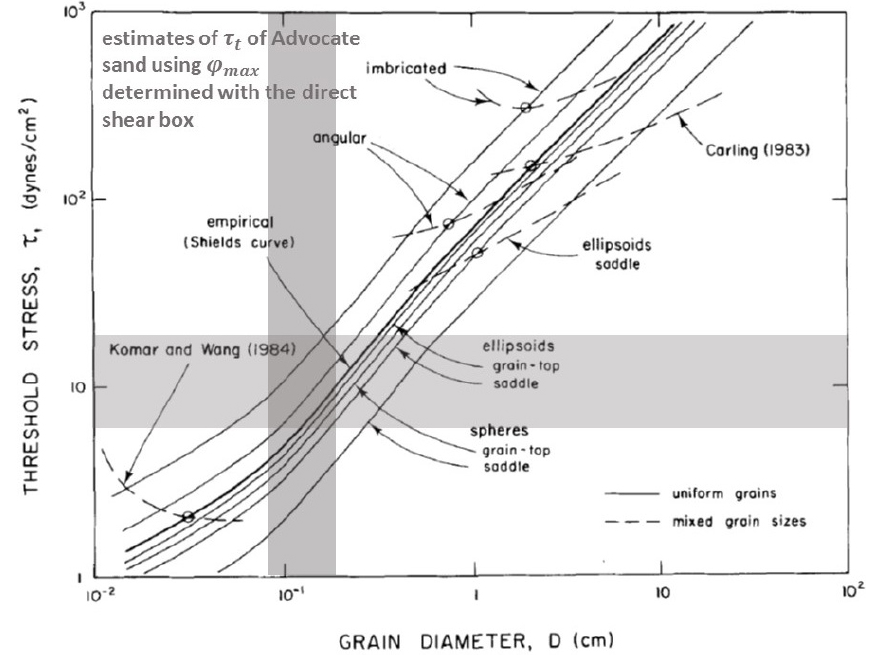
Figure 9. Estimated range of threshold stress based on the shape measurements and direct shear tests of the Advocate sands plotted as the dark gray shade into a scheme by Komar and Li (1986). Our results agree well with their measurements of imbricated, angular and ellipsoid particles in the same size range.